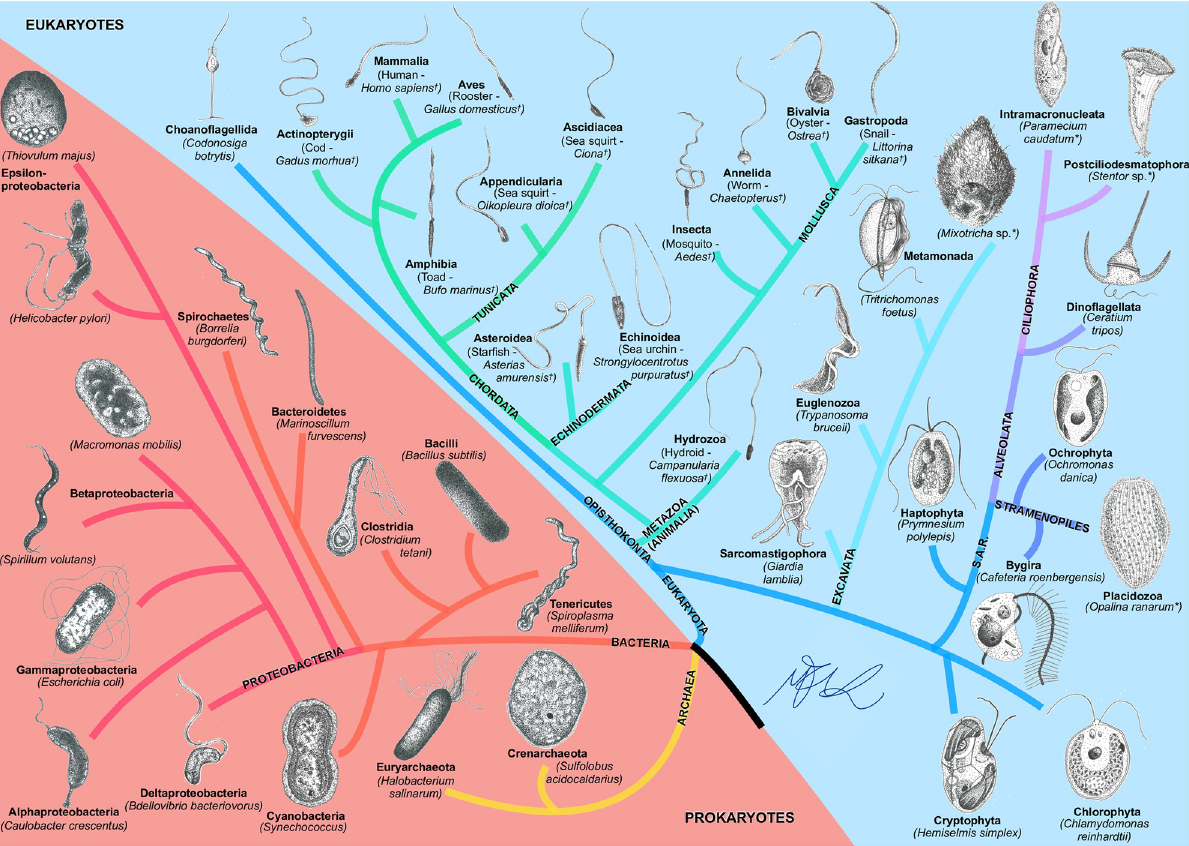
Fig 3. BOSO-Micro Tree of Life. The taxonomy was obtained from the Open Tree of Life [65]. Ciliates are indicated by an asterisk � , and spermatozoa by a dagger † beside their species’ names. The drawings are not to scale and were inspired by real microscopy images or by illustrations. All drawings by Marcos F. Velho